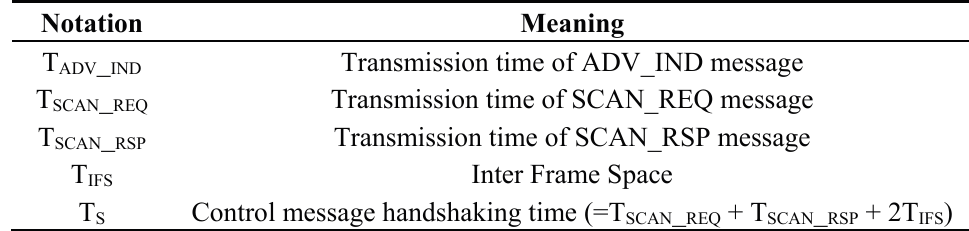
Figure 2. Control messages for discovery process and their transmission